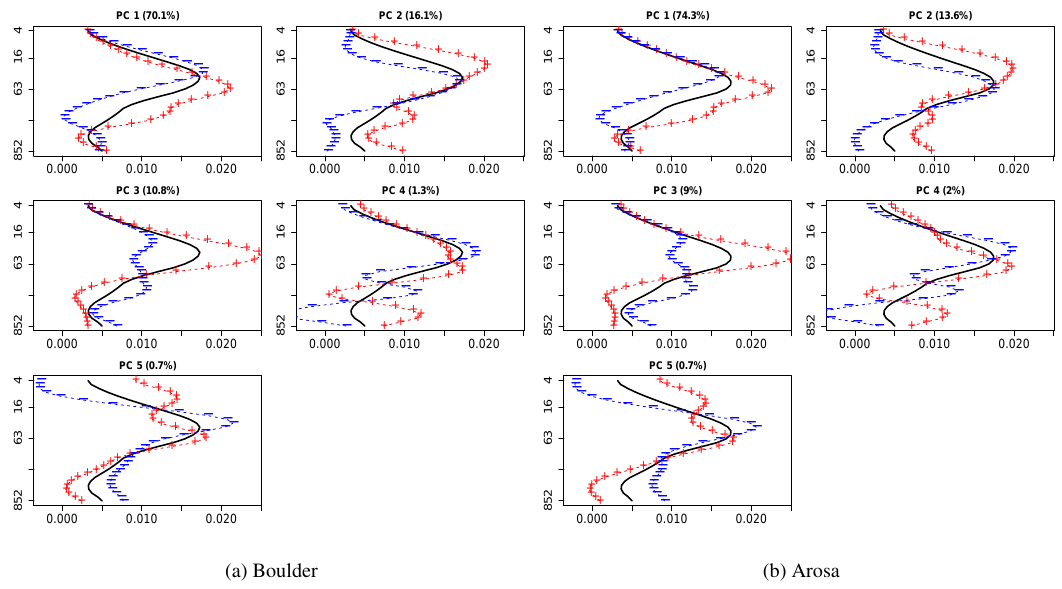
Fig. 2. The effects of five PC functions on the mean ozone profile. It displays the mean curve as a solid line, along with ( + ) and ( − ) indicating the exaggerated consequences of adding and subtracting a multiple of each PC. Dashed lines are drawn in addition to ( + ) to improve the visual quality. The x axis refers to ozone level in DU (scaled by 1000), and the y axis to atmospheric pressure (hPa). The variance contribution in % of each PC to total ozone variability is placed at the top of each panel.